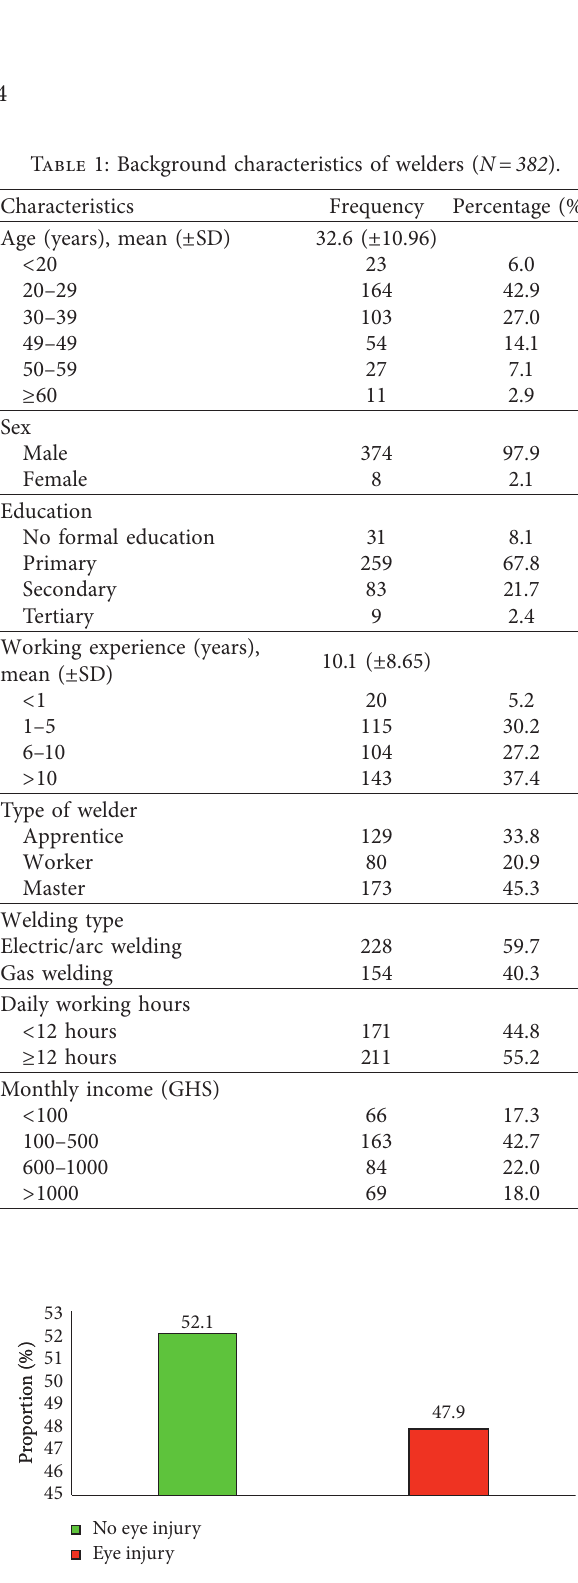
Figure 1: Overall distribution of self-reported eye injuries among welders in the study.